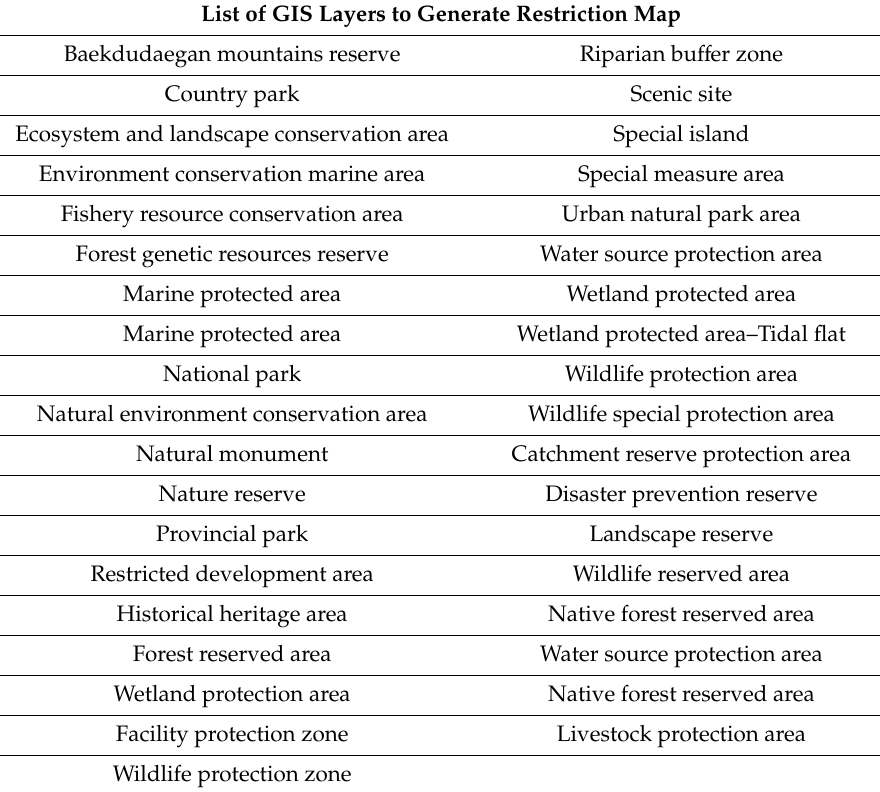
Table 4. List of spatial data used to develop the restriction